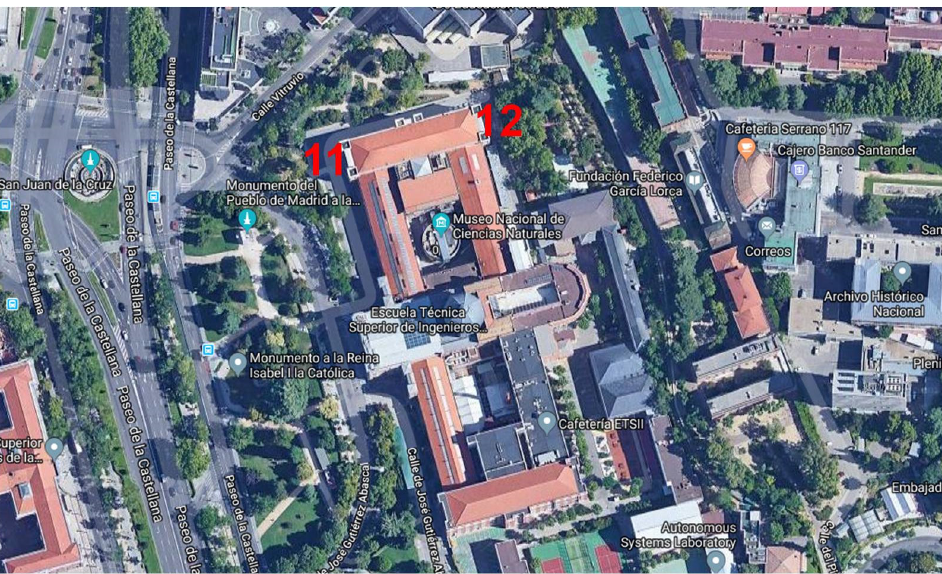
Figure 8. Location of the MNCN in downtown Madrid and position of outdoor sensors 11 and 12.